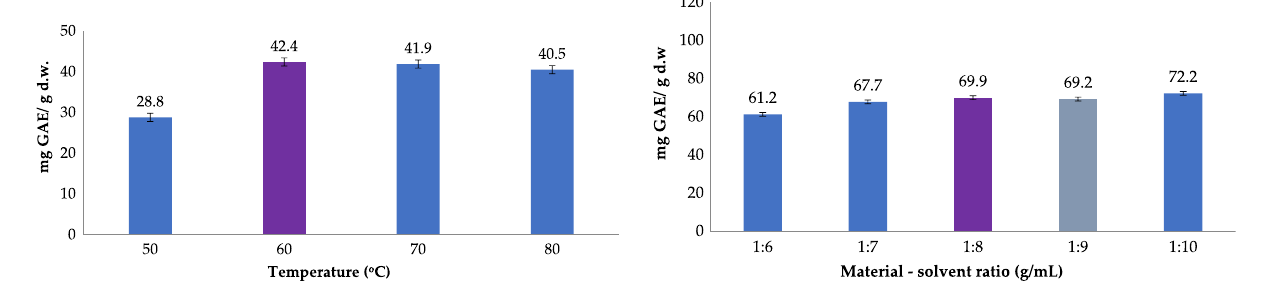
Figure 2: Polyphenol extraction a ff ected by temperature ( Operating conditions: ethanol concentration of 70% ( v/v ) ; material – solvent ratio of 1:5 g/mL; operating time of 30 min; and 2 extraction cycles ) .